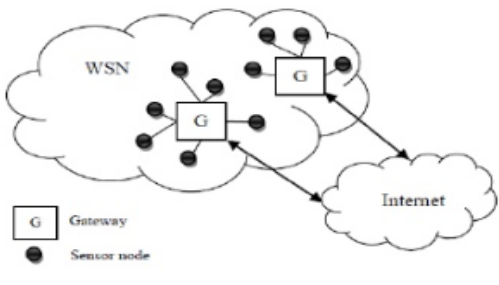
Fig. 1 High level view of building automation by WSN integrated with Internet.